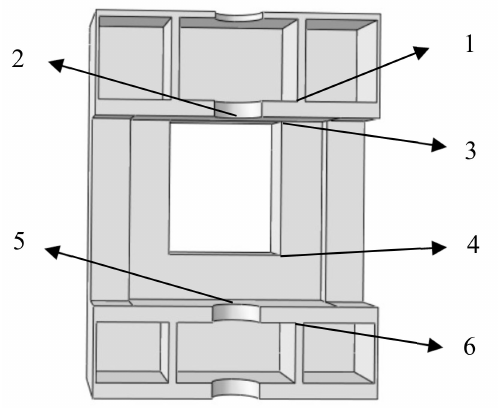
Figure 6. Large stress positions of the COF machine.